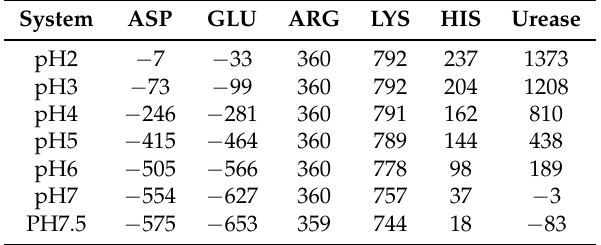
Table 1. Charge as a function of pH for titrable amino acids and for the entire structure of the urease. System ASP GLU ARG LYS HIS Urease pH2 − 33 360 792 237 1373 pH3 − 99 360 792